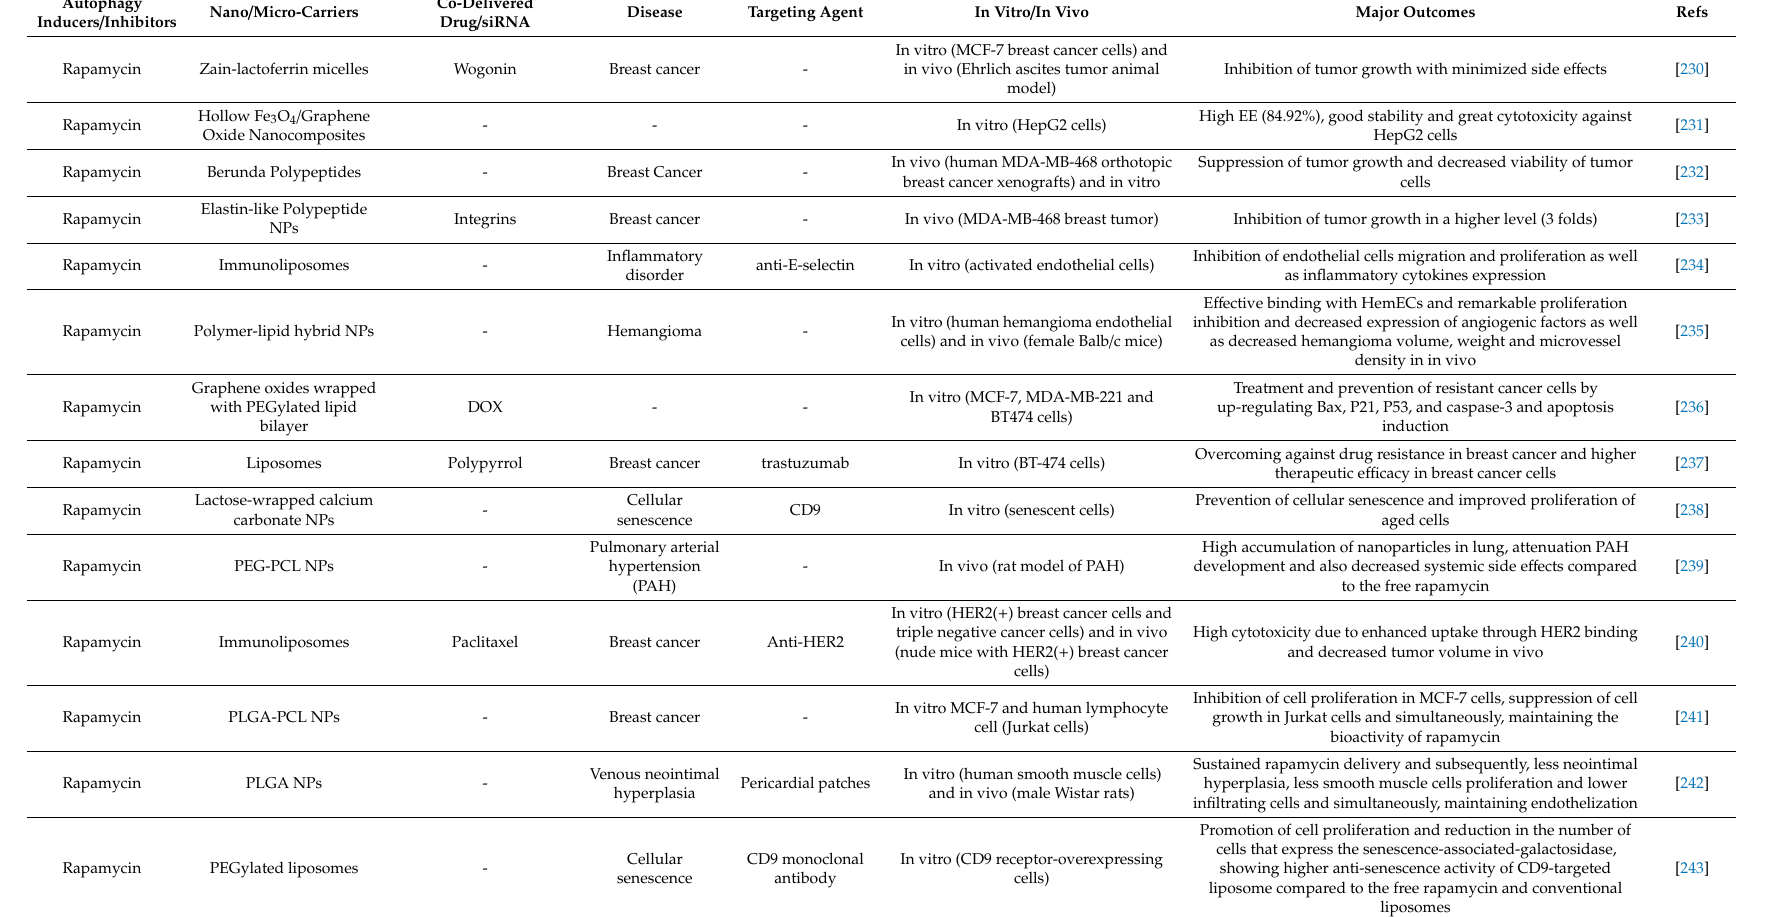
Table 1. Nanocarriers for autophagy modulators